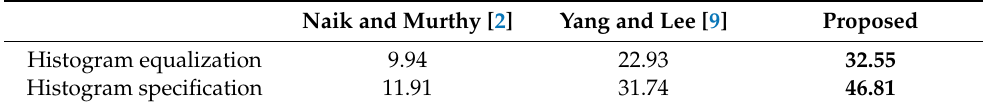
Table 2. Mean saturation, where the maximum value in each row is indicated in